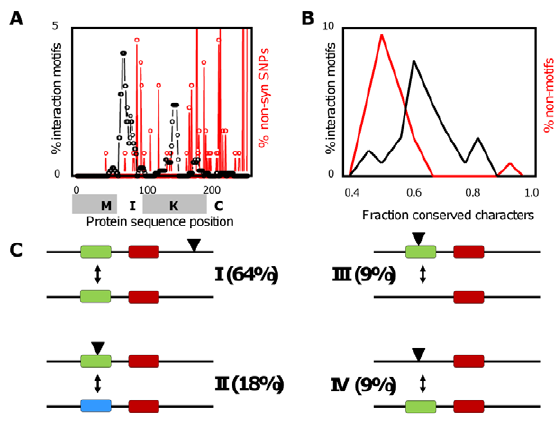
Figure 4. Interaction motifs and network evolution. The role of conservation of interaction motifs versus variation of these motifs was investigated. ( A ) Histogram of occurrences of interaction motifs (black) and SNPs (red) at particular positions in the protein sequences of all Arabidopsis MIKC MADS proteins. Note that there is hardly any overlap between interaction motifs and SNPs. Positions of the M, I, K and C domain are indicated. ( B ) Histogram of cross-species conservation of interaction motifs (black) and non-motif-sequences (red) in MIKC MADS domain protein sequences. Non-motif sequences are defined at positions in MADS protein sequences where in other MADS sequences a motif is present. ( C ) Four different scenarios are possible if after duplication of a MADS domain protein sequence an indel occurs in one of the two sequences: (I) indel does not overlap with a predicted interaction motif; (II) both insertion and deletion overlap with a motif; (III) only insertion or (IV) only deletion overlap with a motif. Lines indicate sequences, colored boxes indicate predicted interaction motifs, triangles indicate insertion, and arrows indicate effect of insertion/ deletion on motif. As discussed in the text, if an indel overlaps a motif (scenario II-IV), in half of the cases (18% for scenario II vs 9% for each of scenario III and IV) it does not delete but only modifies the motif (illustrated by a change in color for the motif).